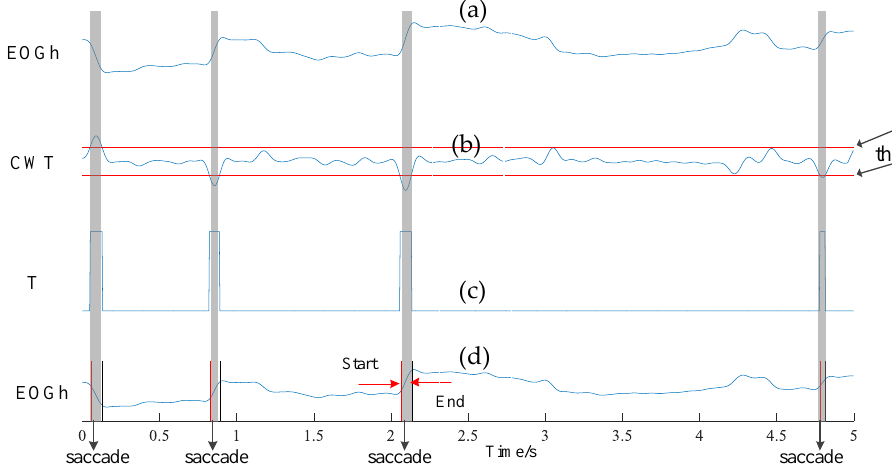
Figure 6. The process of saccade detection. ( a ) Raw horizontal EOG signal; ( b ) wavelet coefficient with detection threshold ± th ; ( c ) the detection results of saccade and non-saccade, and ( d ) corresponding saccade segments in terms of outputs from subfigure ( c ).